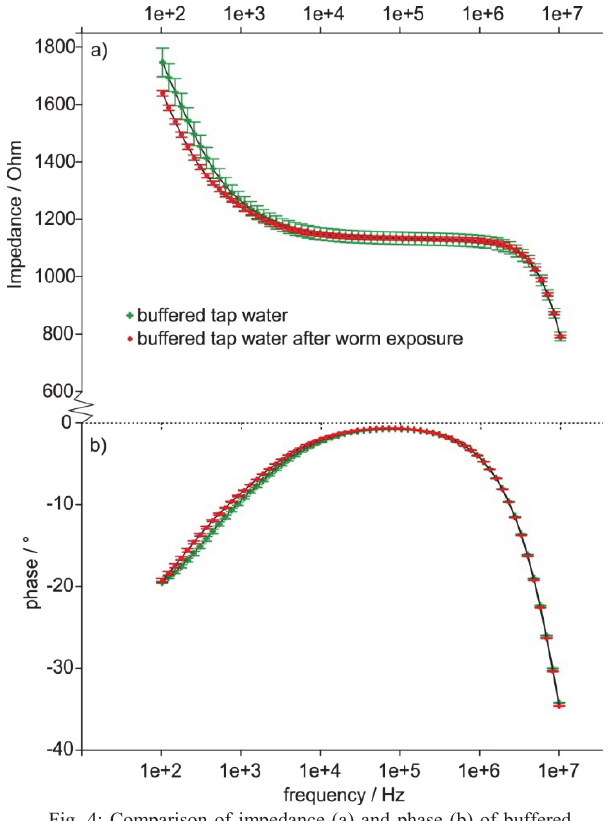
Fig. 4: Comparison of impedance (a) and phase (b) of buffered tap water before and after 60 minutes exposure to living aquatic worms.